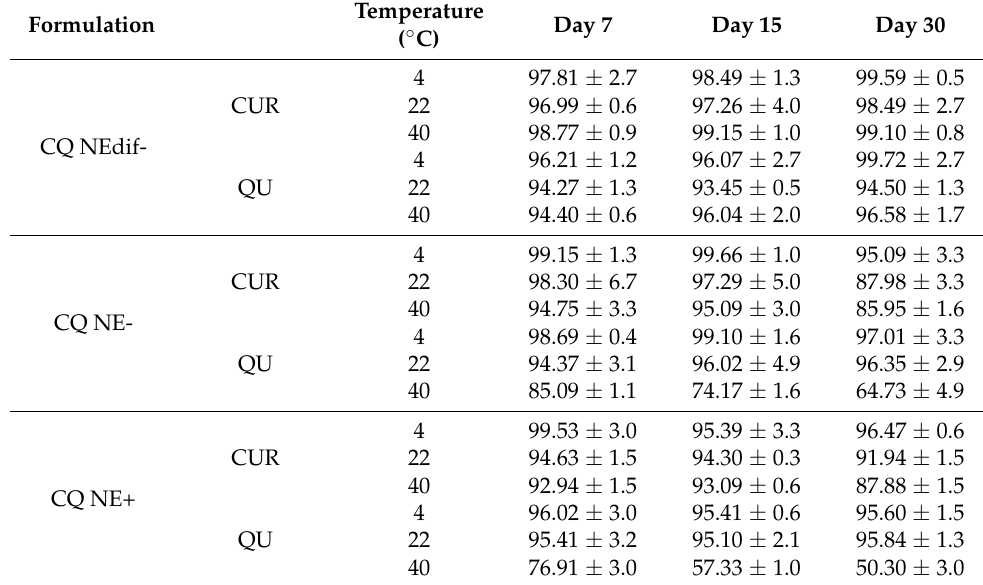
Table 3. Percentage (%) of the CUR and QU in the NEs (CQ NEdif-, CQ NE-, CQ NE+) during 30-day stability studies at 4, 22, and 40 ◦